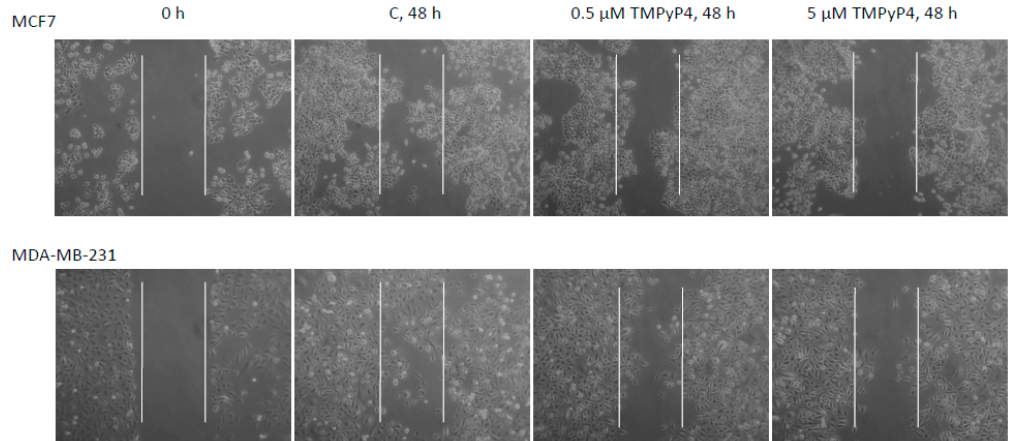
Figure 7. TMPyP4 triggers migration impairment in breast-cancer cells. MCF7 and MDA-MB-231 cells were incubated until reaching ca 70% confluence followed by a scratch with a sterile pipette tip. Samples were treated for 48 h with TMPyP4 (0.5 or 5 µM), and the wound healing properties were documented using a Zeiss Axiovert microscope (magnification 100 ×). Typical result out of 3 replicates was demonstrated.